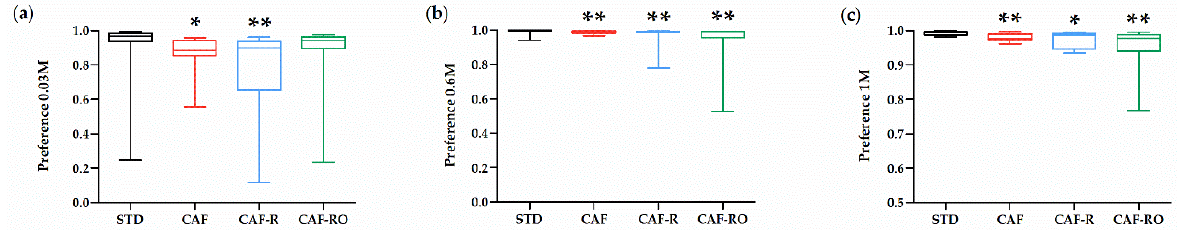
Figure 2. Effects of the dietary treatments on the sucrose preference at 0.03 M ( a ), 0.6 M ( b ) and 1 M ( c ) sucrose solutions in the two-bottle preference test. Sucrose preference ratio was calculated according to the formula: sucrose solution intake (g)/water + sucrose solution intake (g). Data are expressed as the mean ± SEM. * p < 0.05; ** p < 0.01 vs. STD group.